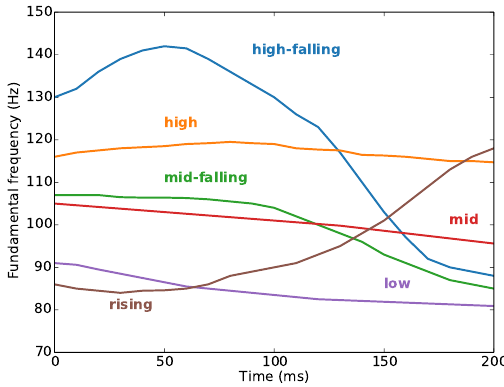
Figure 1. F 0 contour of six Isarn